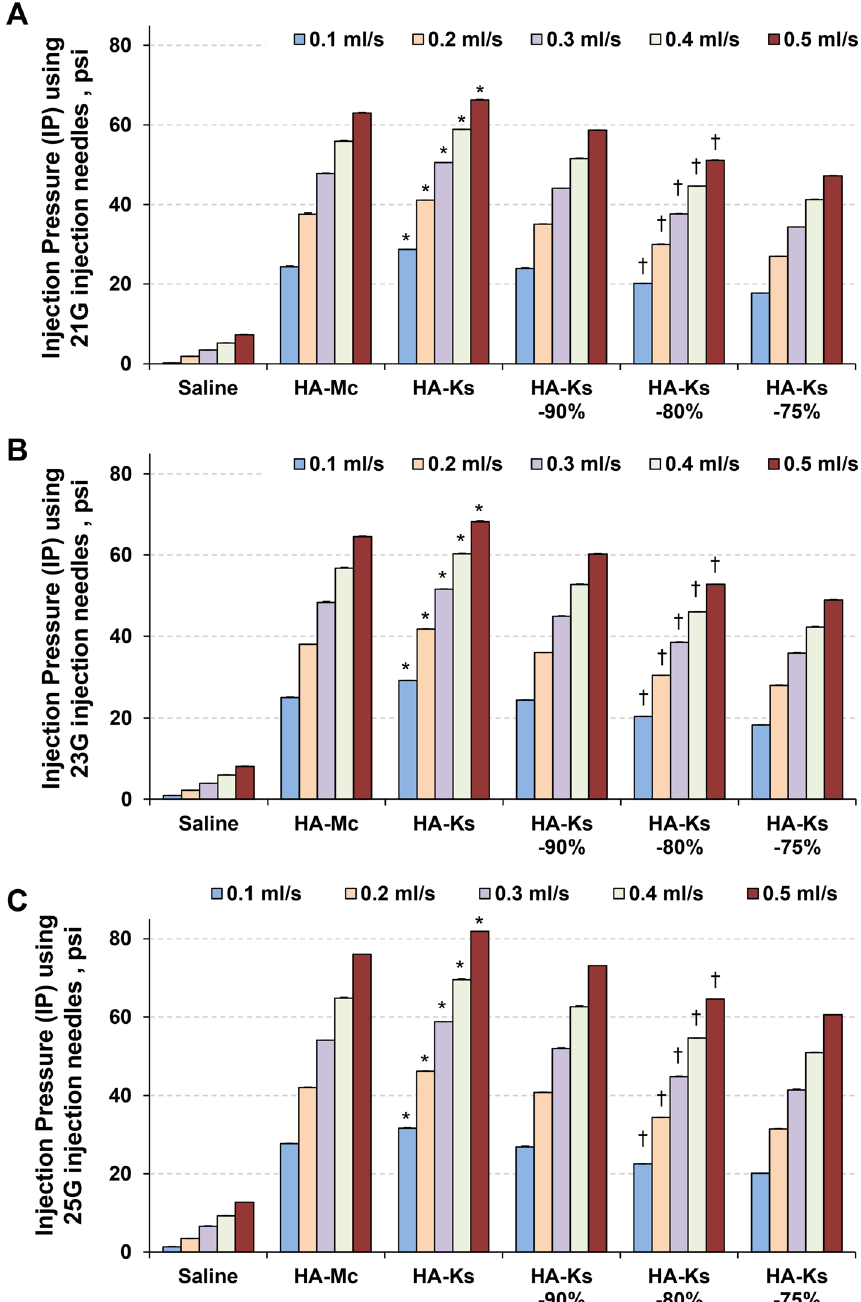
Figure 4. Injection pressure (IP) of saline, HA-Mc, HA-Ks, HA-Ks-90%, HA-Ks-80%, and HA-Ks-75%. ( A ) With a 21-gauge endoscopic injection needle, the IP of saline, HA-Mc, HA-Ks, HA-Ks-90%, HA-Ks-80%, and HA-Ks-75% was measured at an injection speed rate of 0.1, 0.2, 0.3, 0.4, or 0.5 mL/s. ( B ) Using a 23-gauge endoscopic injection needle, a similar IP measurement was performed. ( C ) Using a 25-gauge endoscopic injection needle, a similar IP measurement was performed. IP, injection pressure; HA-Mc, sodium hyaluronate- based submucosal injection material (MucoUp); HA-Ks, sodium hyaluronate-based submucosal injection material (Ksmart). Data are expressed as mean ± standard deviations for at least three independent experiments. * P < 0.001 (HA-Mc vs. HA-Ks). † P < 0.001 (HA-Mc vs.